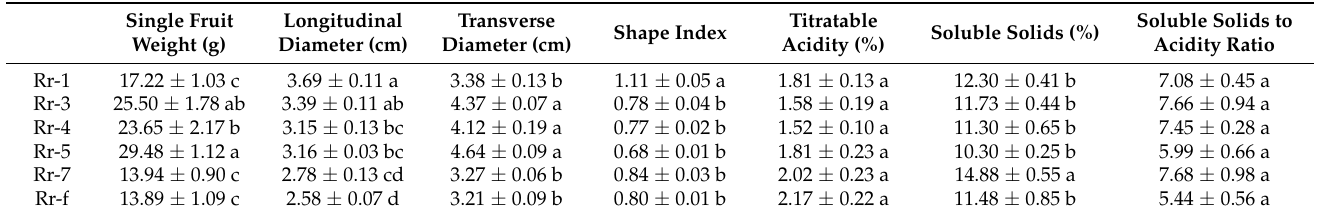
Table 1. Fruit basic quality performance of six R. roxburghii genotypes (Lowercase letters in the table indicate significance, and different letters indicate significant differences among the